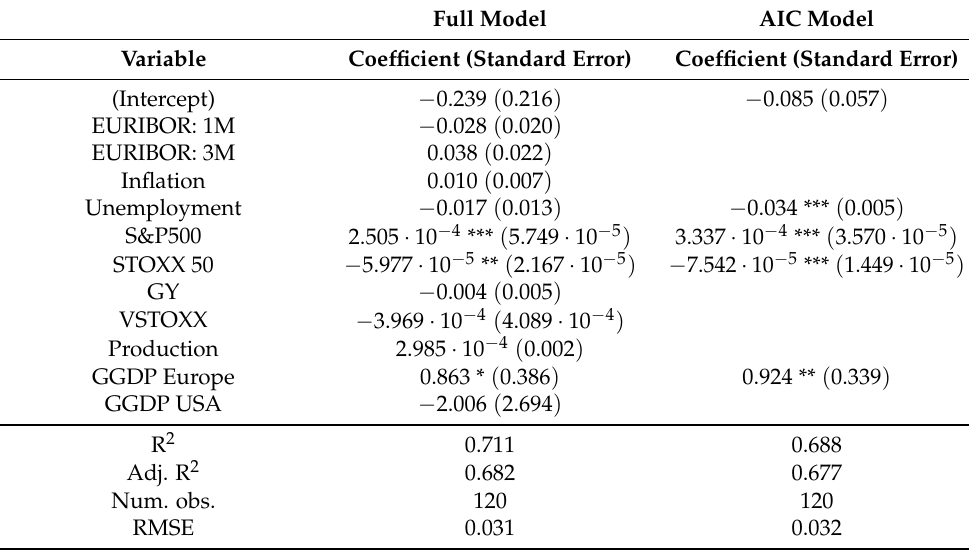
Table 4. Fitted linear regression models (5) and (6) with shifted